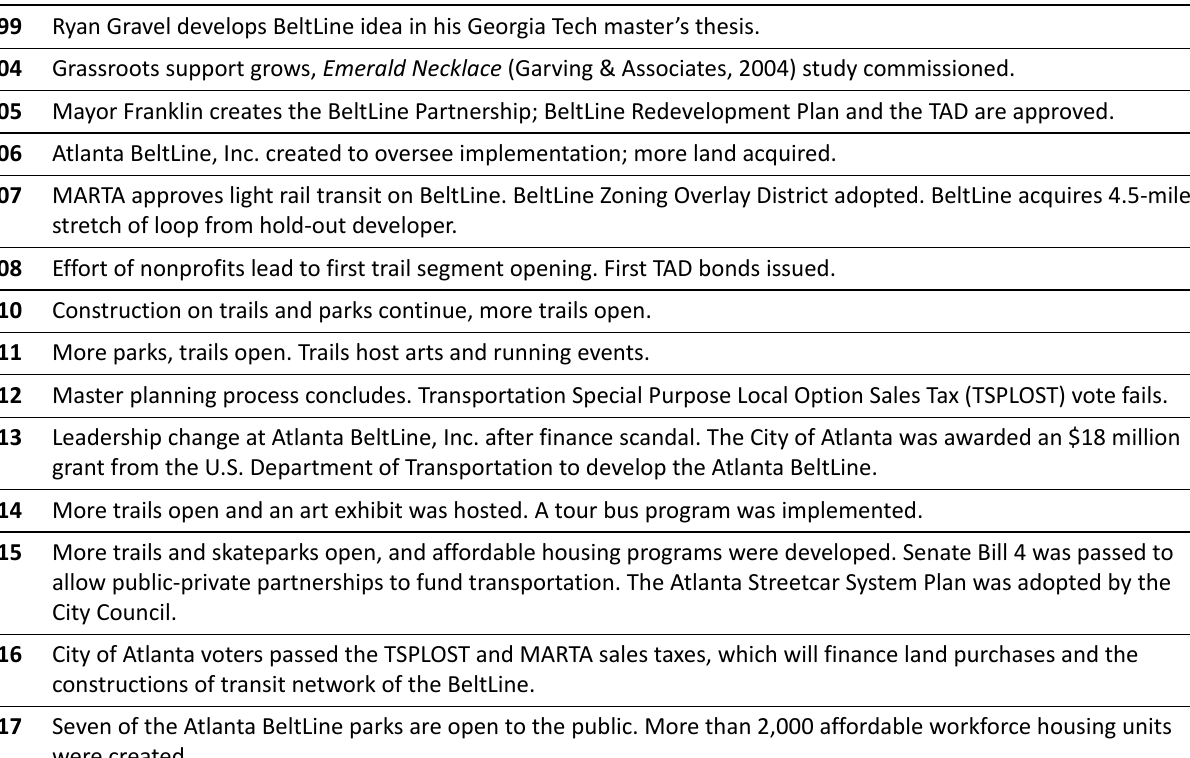
Table 2. BeltLine historical milestones.